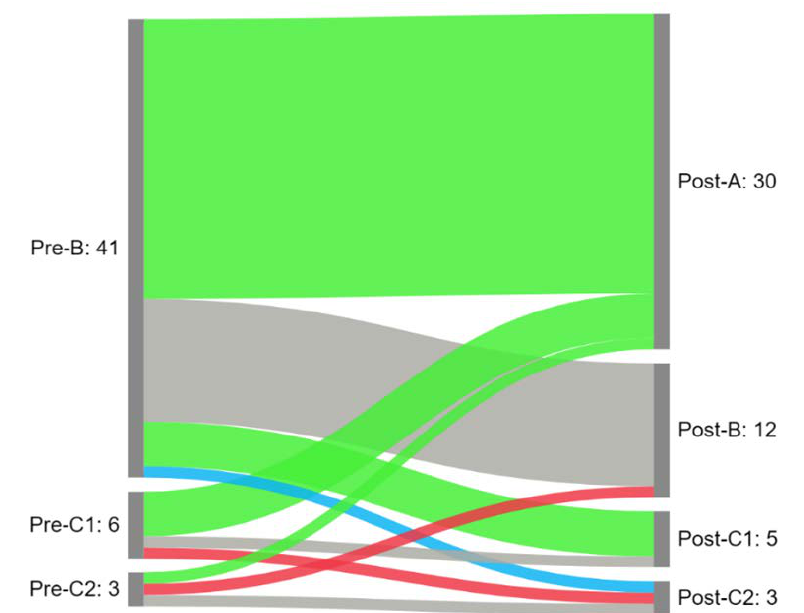
Figure 3. Sankey diagram summarizing patterns of tympanogram change following the interven- tion (green — normalization; blue — improvement; gray — no changes; red — deterioration).